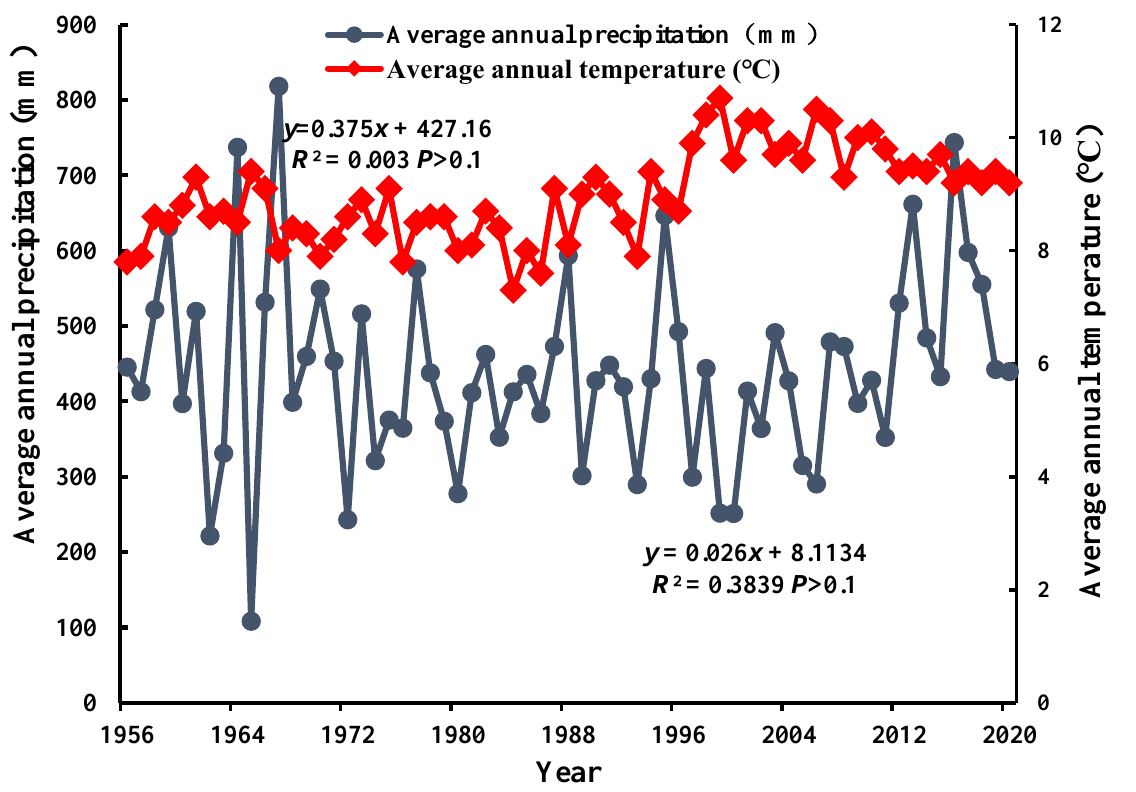
Figure 8. Variations in annual rainfall and temperature in Kuye River Basin from 1956 to 2020 .